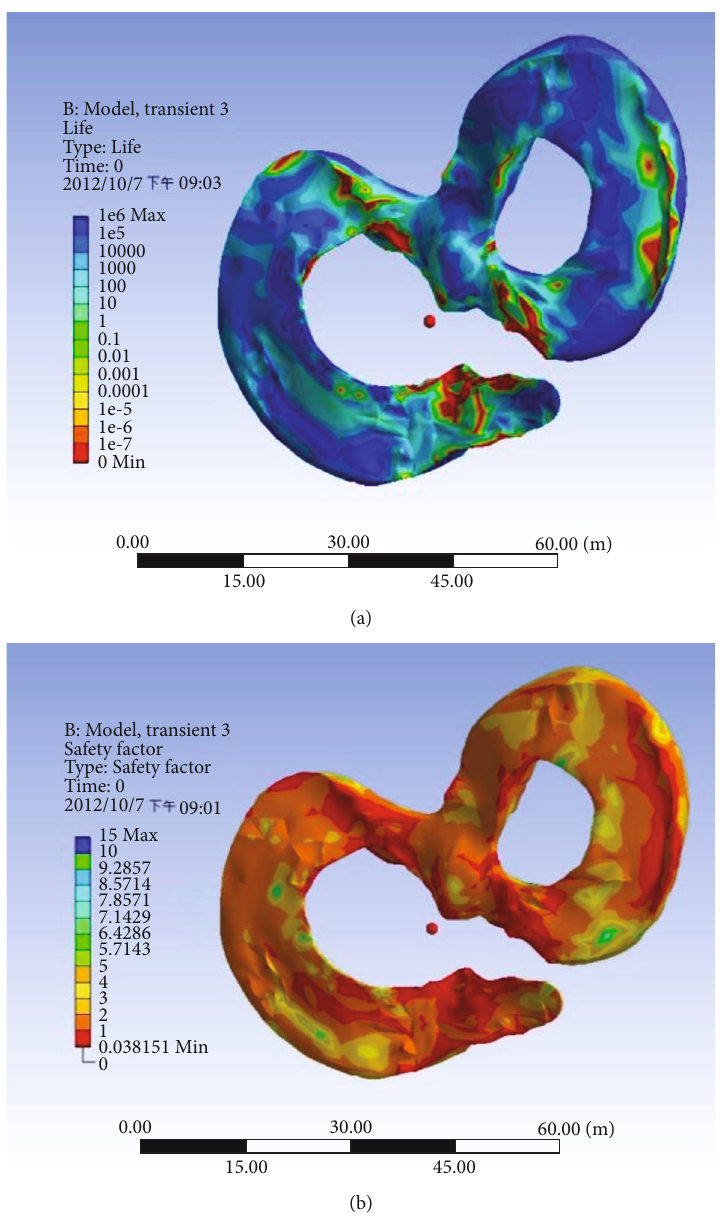
Figure 10: Stress distribution of meniscus under fatigue life analysis. (a) Available cycle. (b) Safety